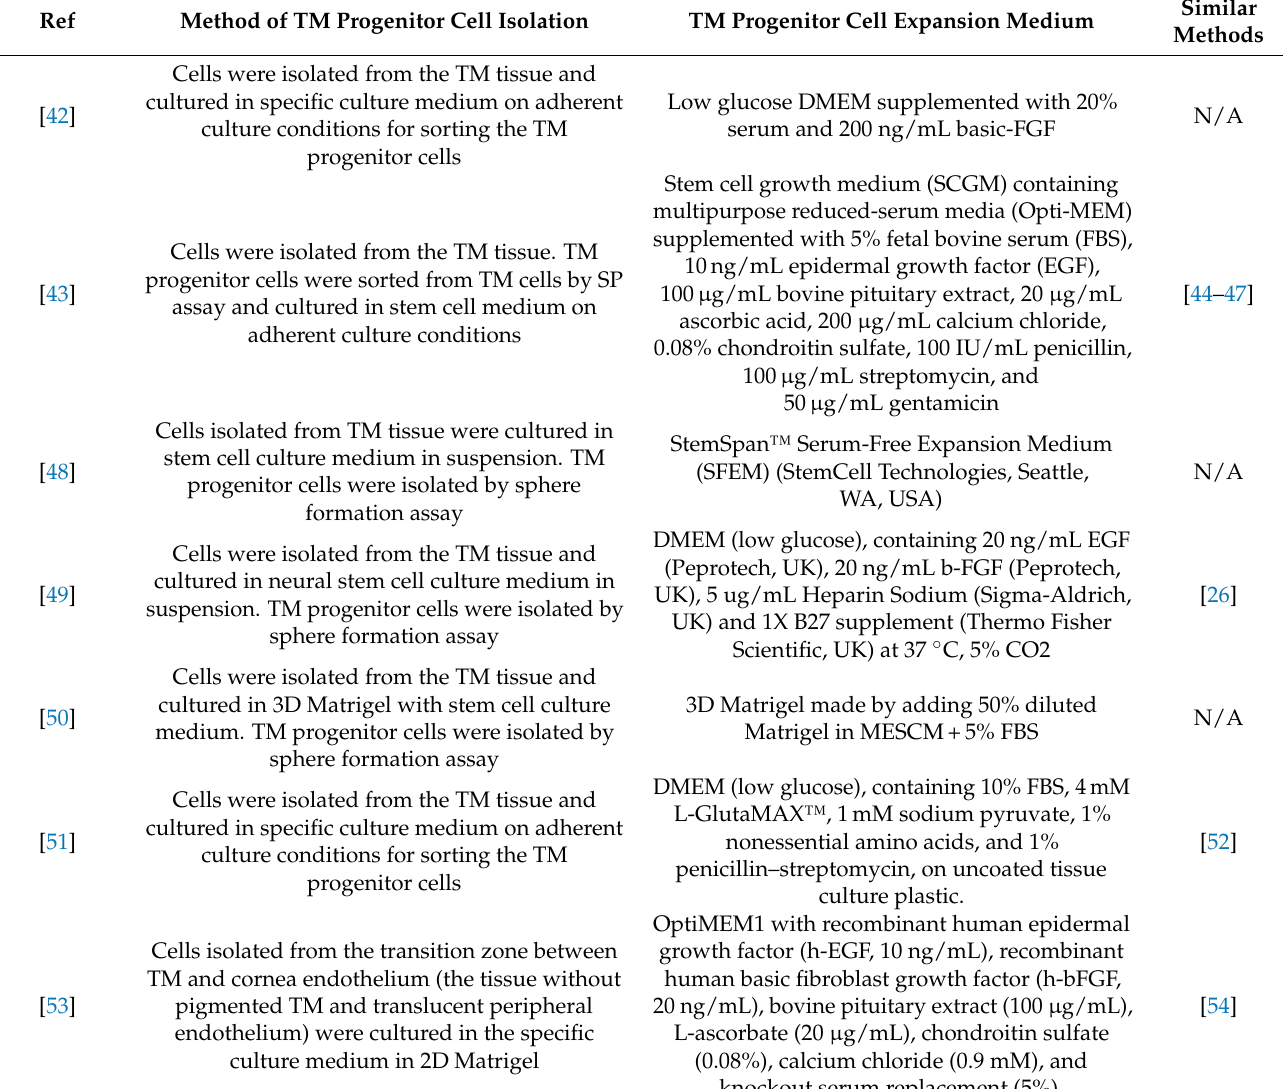
Table 1. Methods of isolation and expansion of trabecular meshwork progenitor